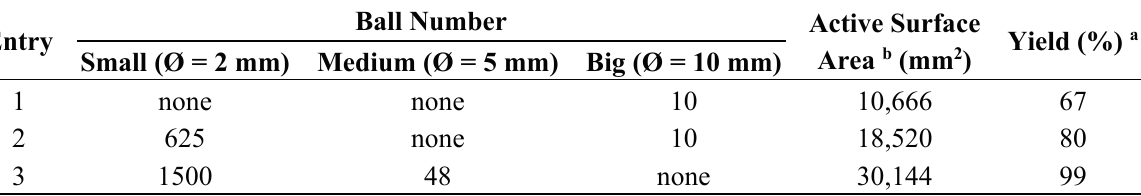
Table 1. Screening of ball